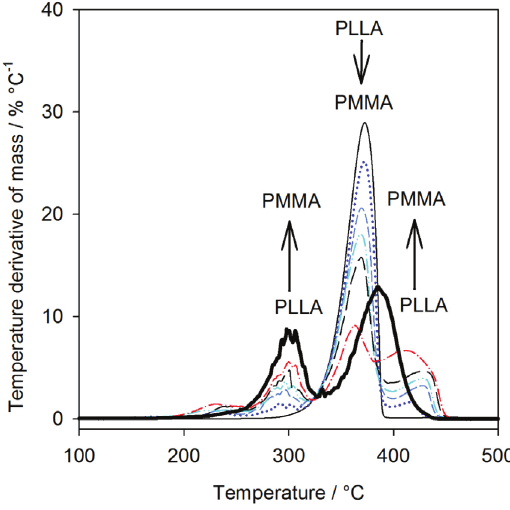
Fig. 10 – DTG curves of pure PLLA, PMMA, and PLLA/ PMMA blends, investigated under a stream of ni- trogen at 10 °C min